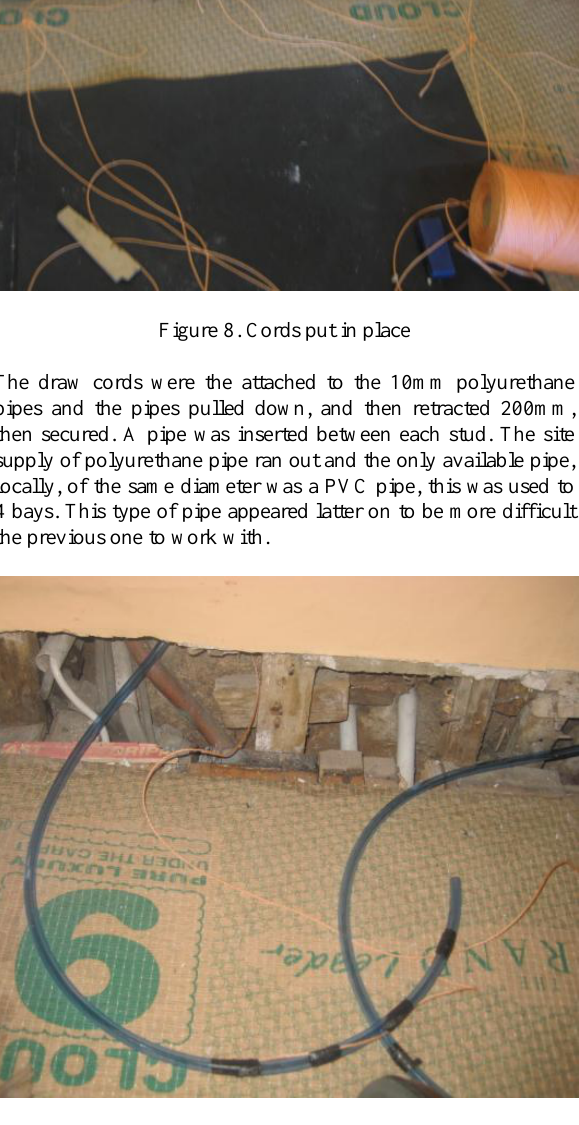
Figure 9. Pipes attached to